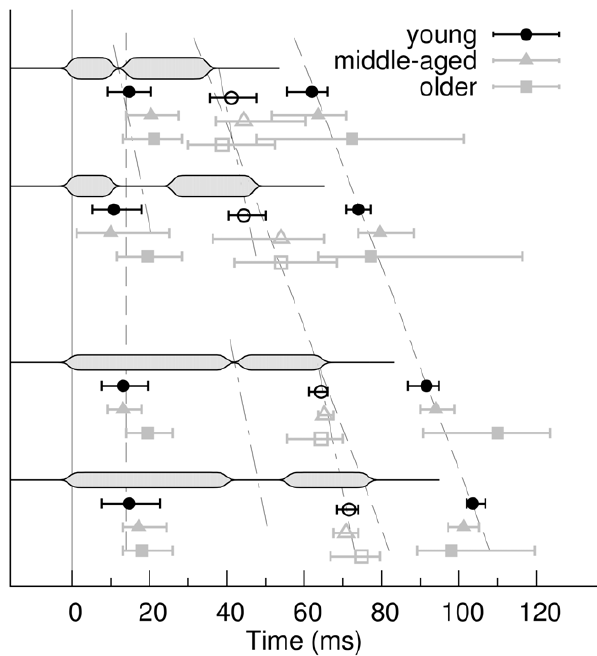
Figure 9. Group mean latencies of the high-gamma peak. Gap responses are marked with open symbols, onset and offset responses to the no-gap stimuli with filled symbols. The error bars denote the 95% confidence intervals for the group means. The dashed lines are parallels to the time points of sound onset and sound offset indicating that the latencies of the response to no-gap stimuli are well explained by a constant delay added to onset or offset latency. The dash-dotted lines are parallels to the mid points of the gaps and suggest that the latency of the gap responses (open symbols) are better explained by a constant delay with respect to the gap mid point.